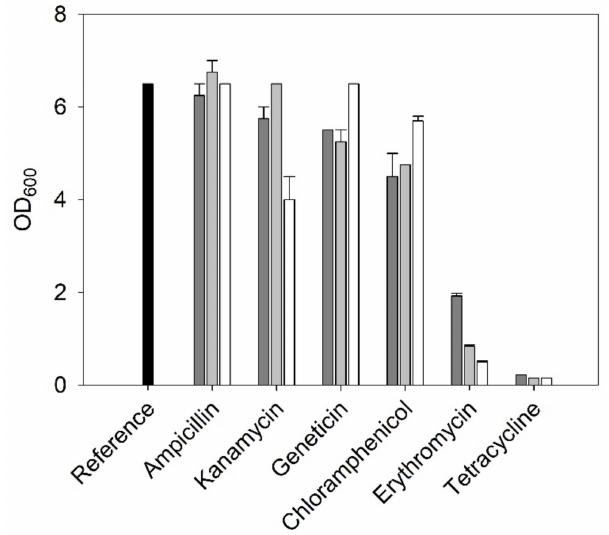
Figure 3. OD 600 values of C. necator cultures in the presence of six antibiotics. Dark gray bars illustrate lowest, light gray bars medium, and white bars highest antibiotics concentrations. Black bar refers to reference cultures without antibiotics. (2 days of cultivation in TSB at 30 ◦